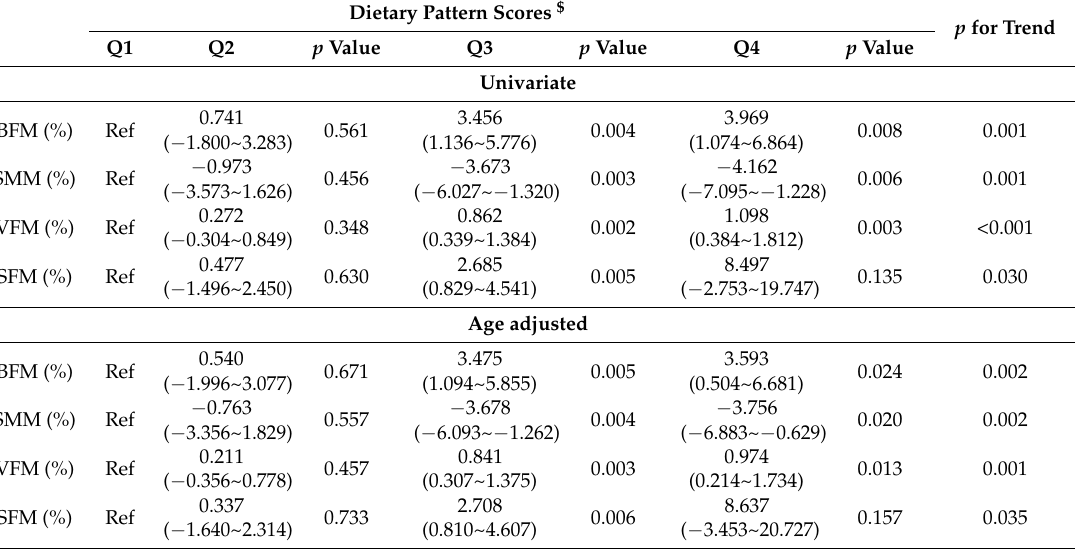
Table 6. Multivariate linear regression of the relationship between quartiles (Qs) of dietary pattern score levels and body composition.